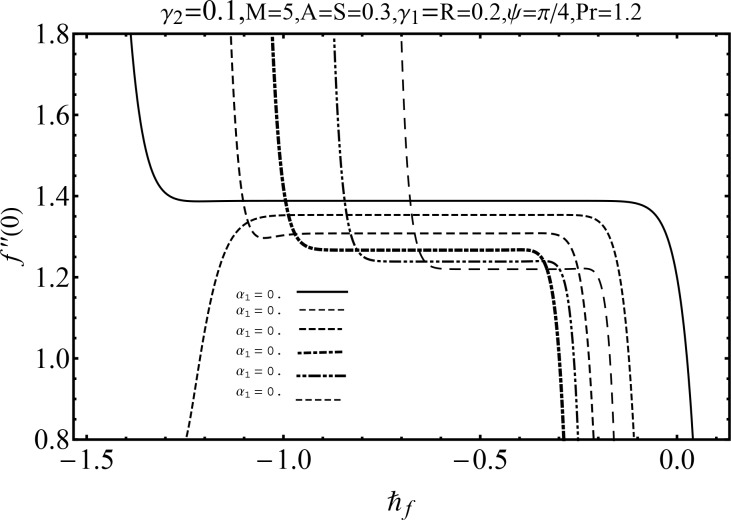
ℏ− curve for f″(0) via various values of α1.